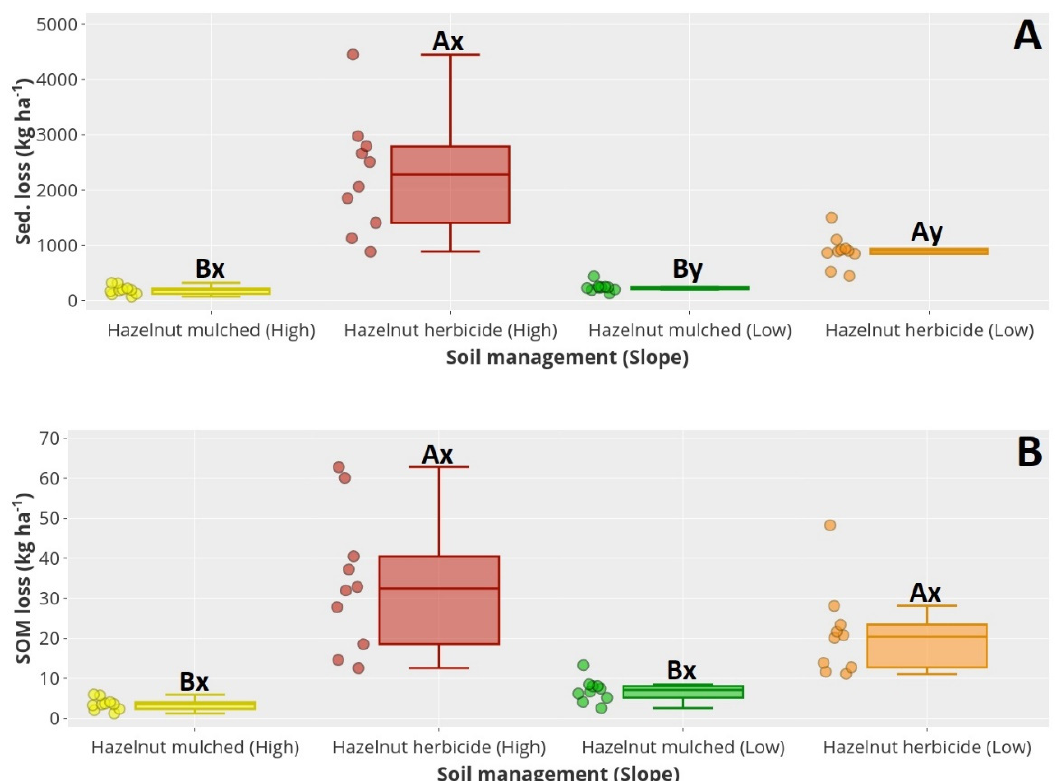
Figure 6. ( A ) Sediment loss (SL), ( B ) soil organic matter loss (SOM loss) distribution according to the soil management and slopes. Upper hanging bar (high edge), lower hanging bar (low edge), upper box line (third quartile), line (median), and lower box line (first quartile). Different uppercase letters (A, B) represent significant differences between soil managements ( p < 0.05). Different lowercase letters (x, y) represent significant differences between slopes ( p < 0.05).